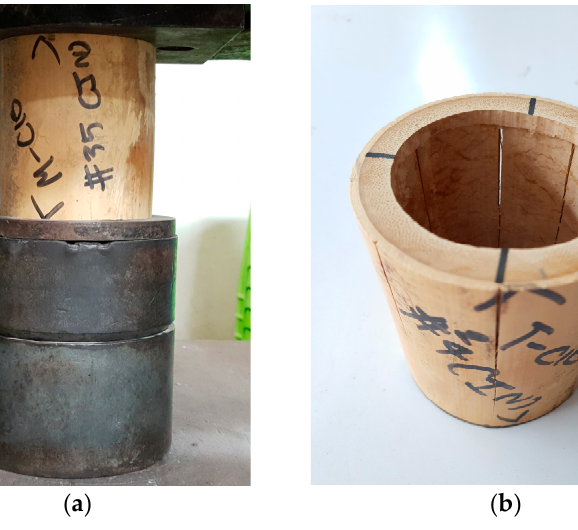
Figure 4. Destructive test: ( a ) compressive strength test ( b ) failure mode of internode bamboo culm, and ( c ) failure mode of node bamboo culm.